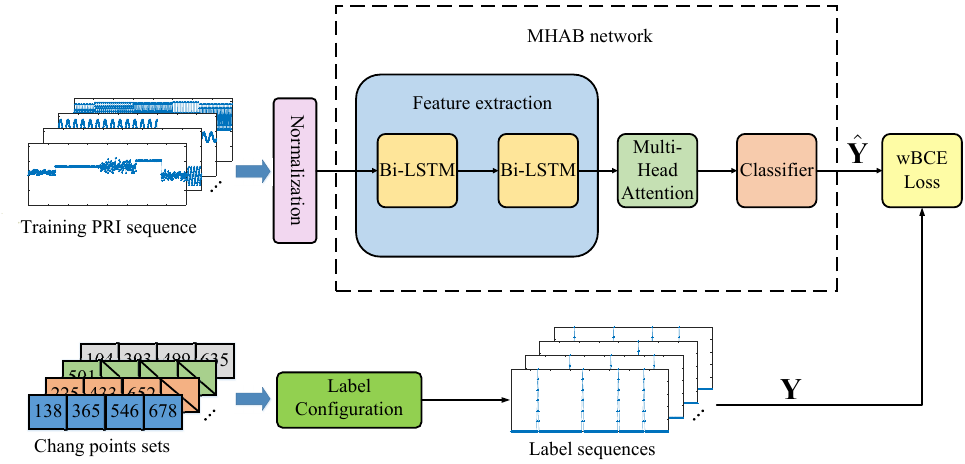
Figure 4. Flow diagram of the proposed MHAB-based CPD